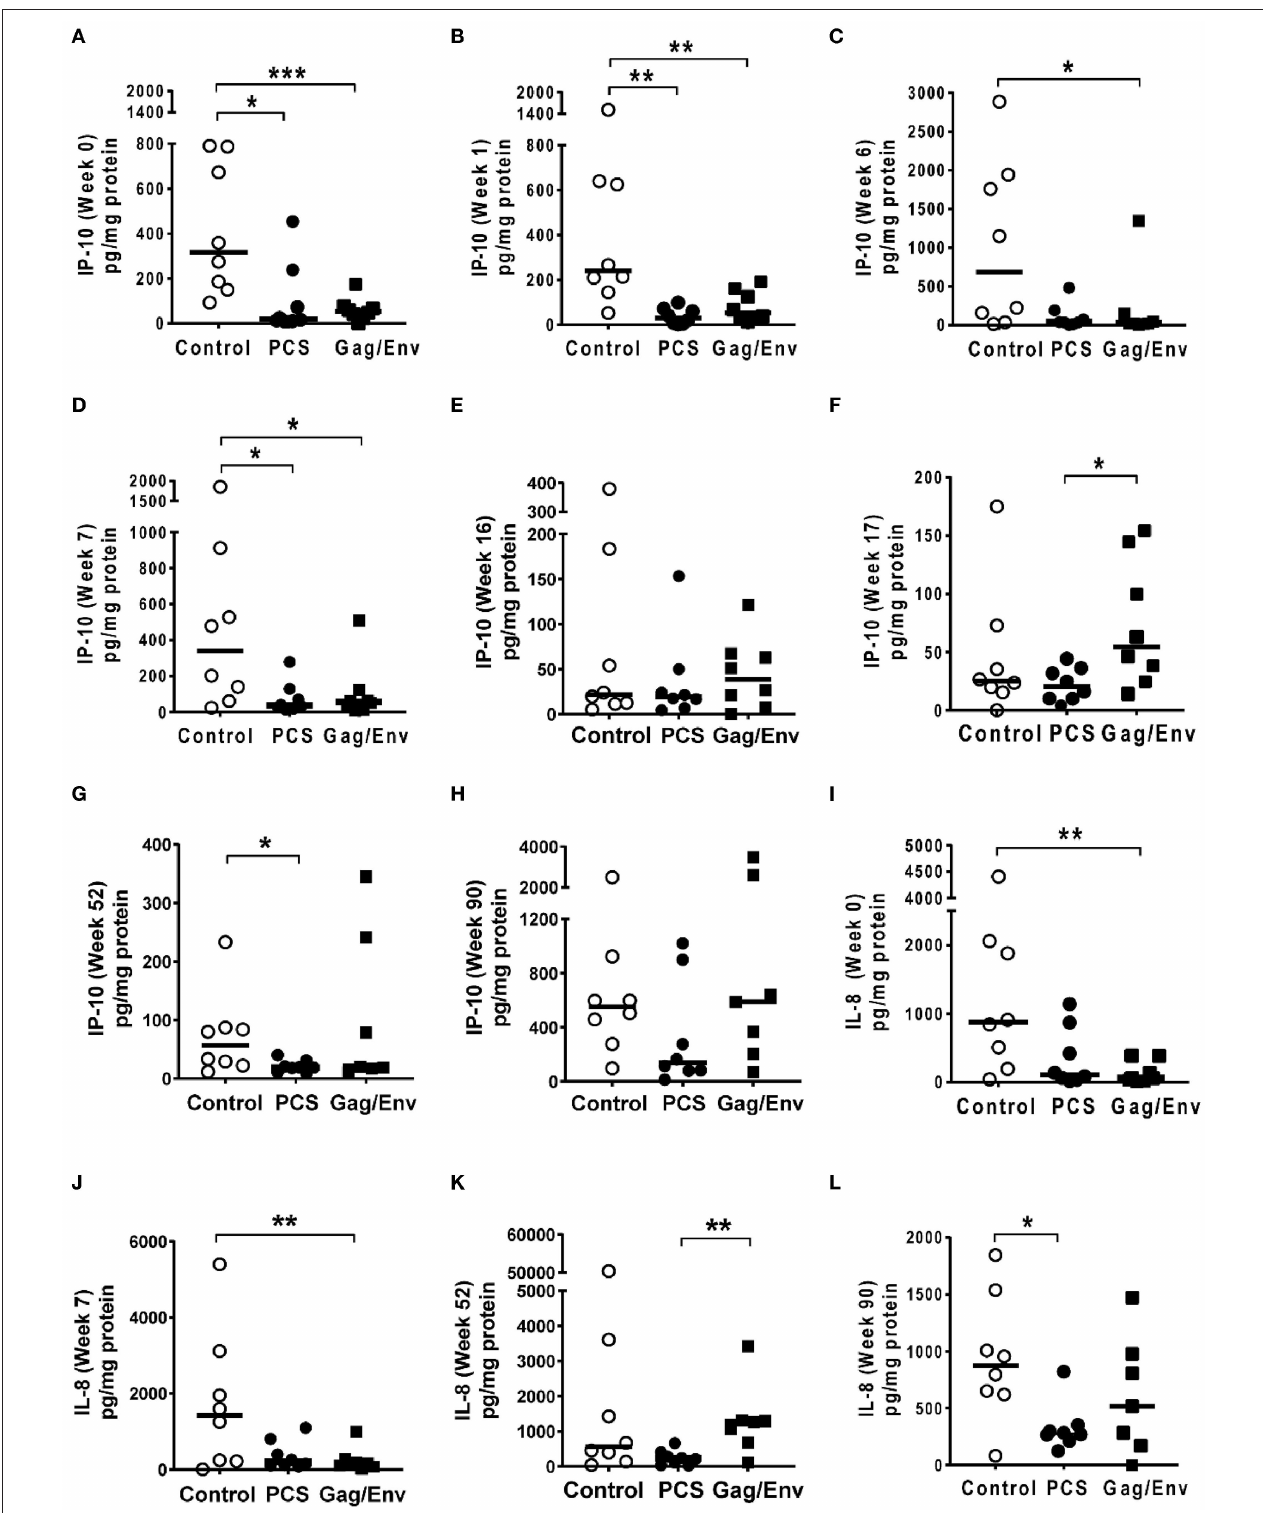
FIGURE 6 | Significant differences in CVL levels of IP-10 and IL-8 among the 3 vaccine groups at different time points including Week 0 and 90 analyzed using Mann- Whitney t -test. Data presented as values from individual monkeys with median. (A–F) IP-10 (G–L) IL-8. n = 8 monkeys/group ( n = 7 for Gag/Env). Experiments were run in duplicates. * P < 0.05, ** P < 0.01, and *** P < 0.001. Non-significant differences between groups were not included.